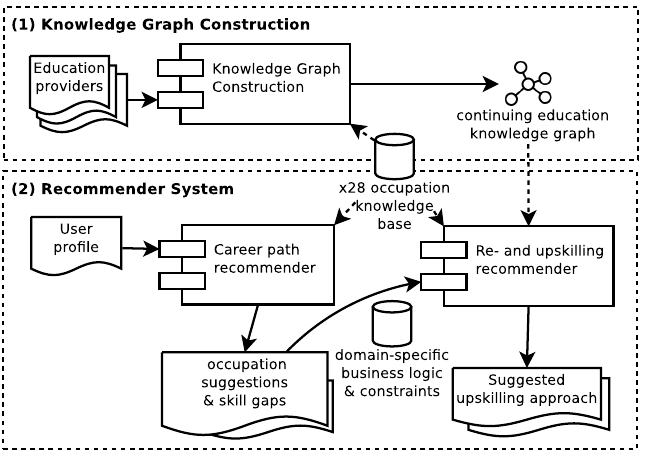
Figure 1. Use of knowledge graphs and ontologies for the suggestion of reskilling and upskilling paths.